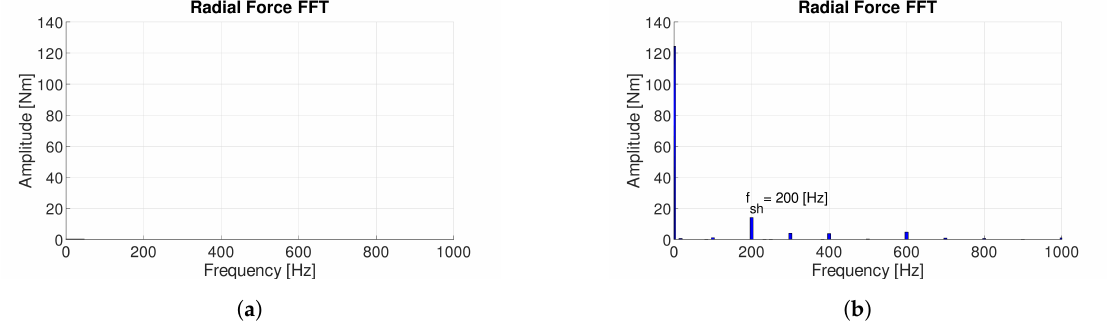
Figure 8. Radial force FFT of 12-14DL without ( a ) and with ( b ) demagnetization. Magnetic axis deviation and PM dislocation affected the torque ripple for the slot–pole combinations with higher performances.